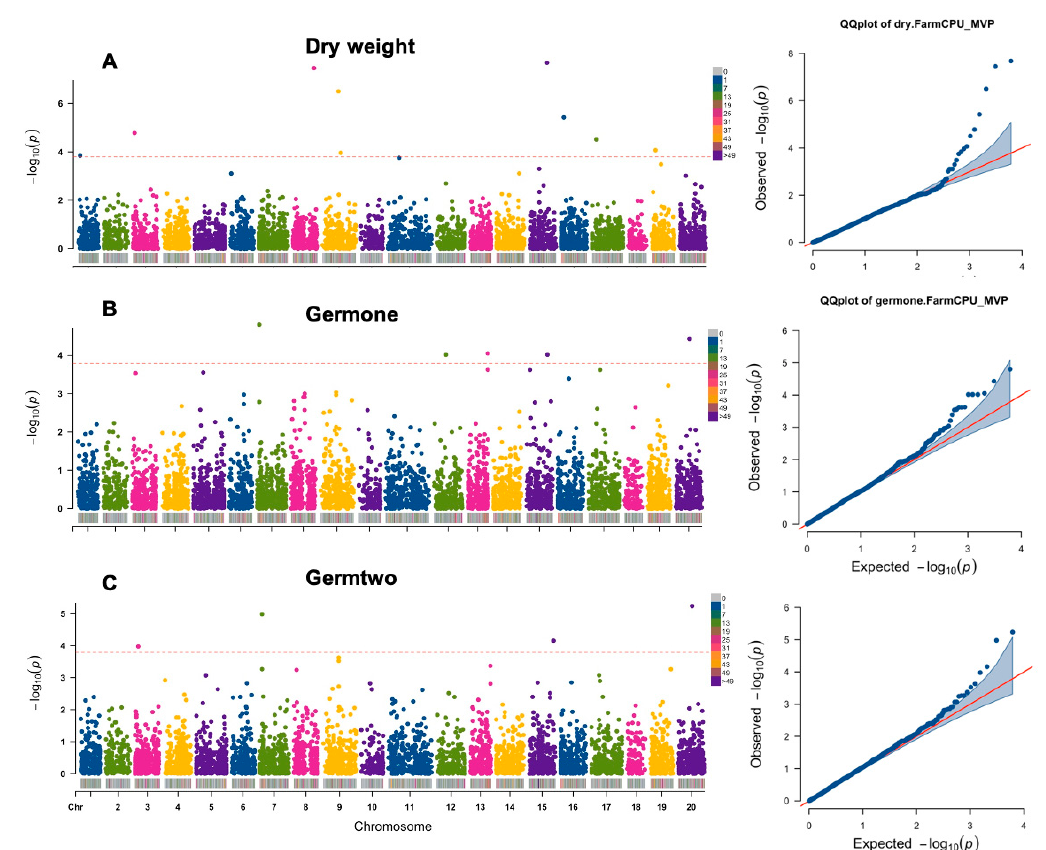
Figure 3. Manhattan plots for significant trait-associated single nucleotide polymorphisms (SNPs) in Camelina sativa under salt stress. ( A ) dry weight; ( B ) germination percentage after 5 days on 100 mM NaCl; ( C ) germination percentage after 9 days on 100 mM NaCl.